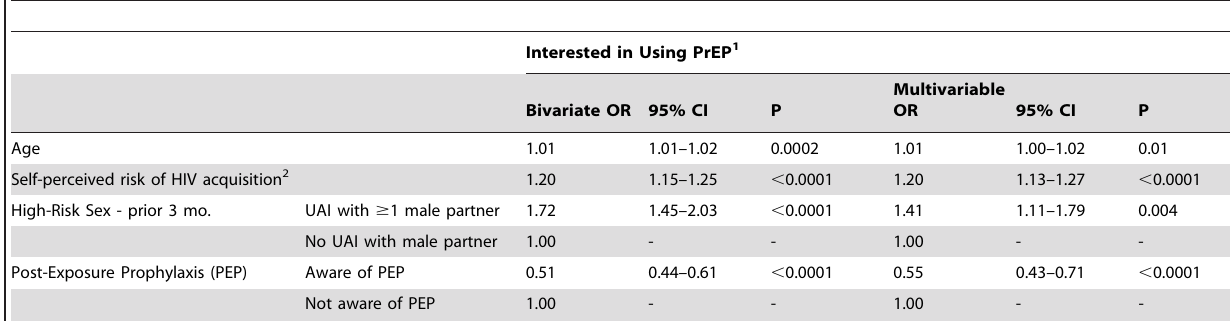
Table 3. Participant Characteristics associated with Interest in Using Pre-Exposure Prophylaxis (n=2 654) One Month after Publication of Efficacy Results (the iPrEx